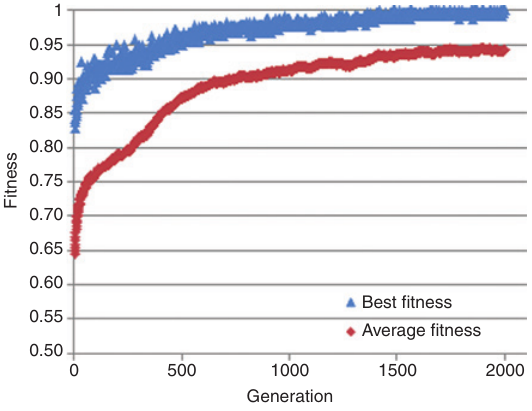
Figure 2: Fitness of Generations for Experiment